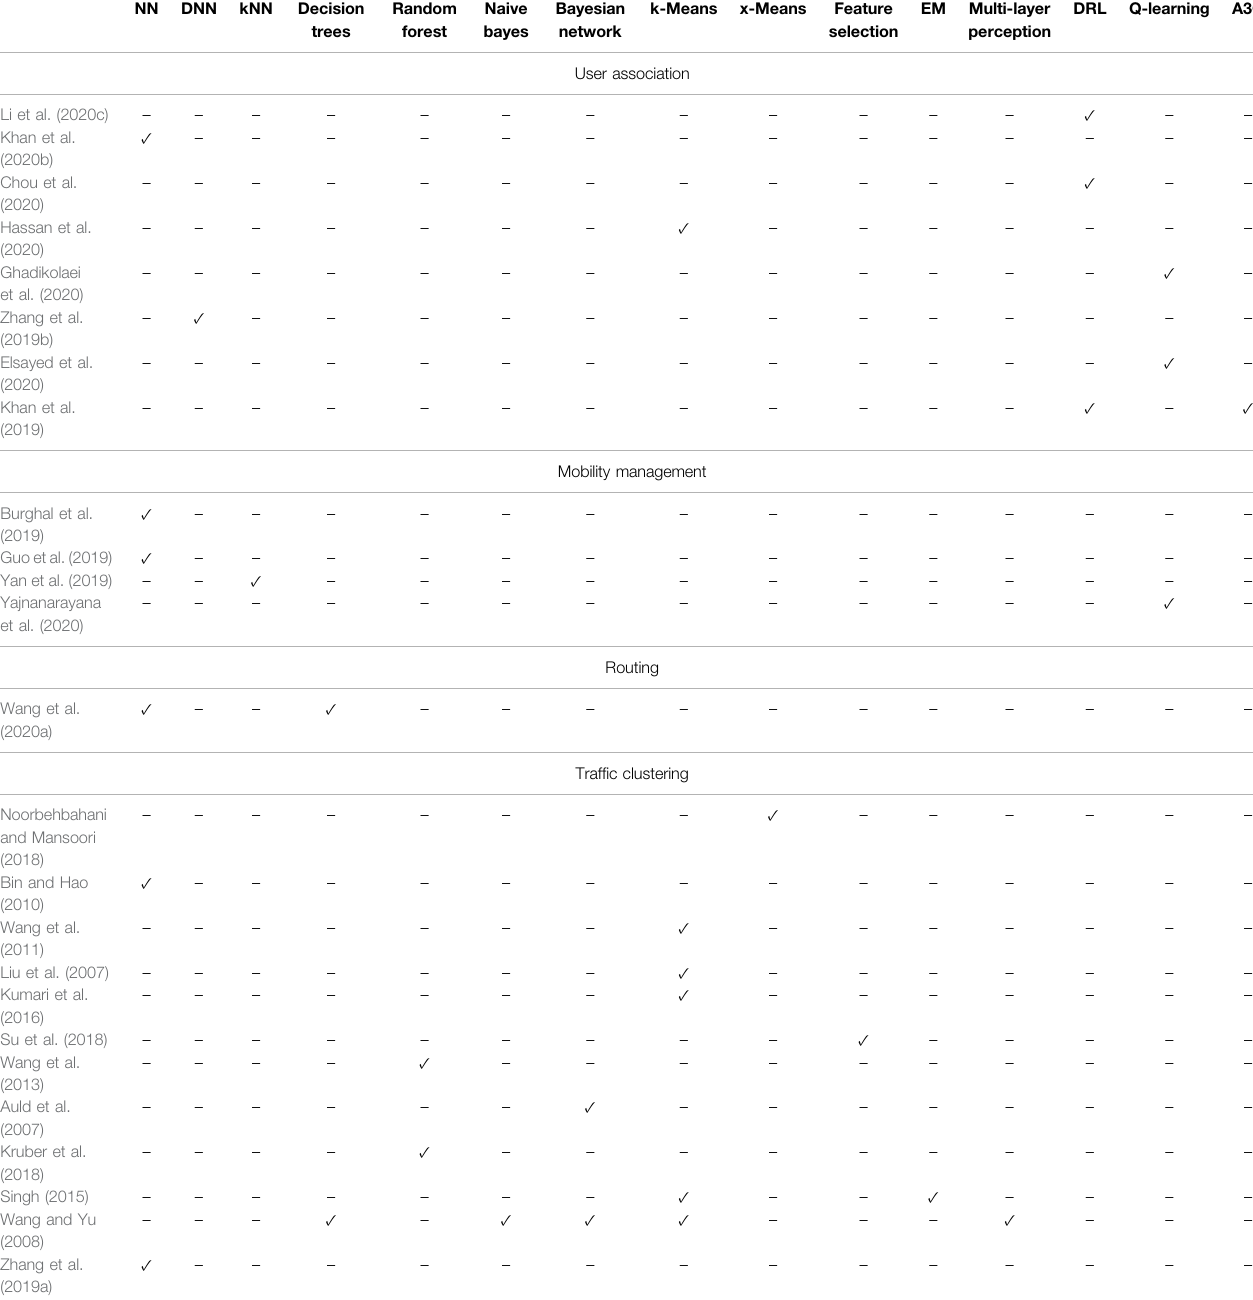
TABLE 4 | ML algorithm types applied in network